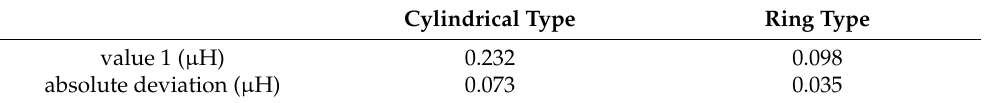
Figure 4. Effect of particle position on coil inductance. Table 1. Effects of detection unit with different structure type of permanent magnet.